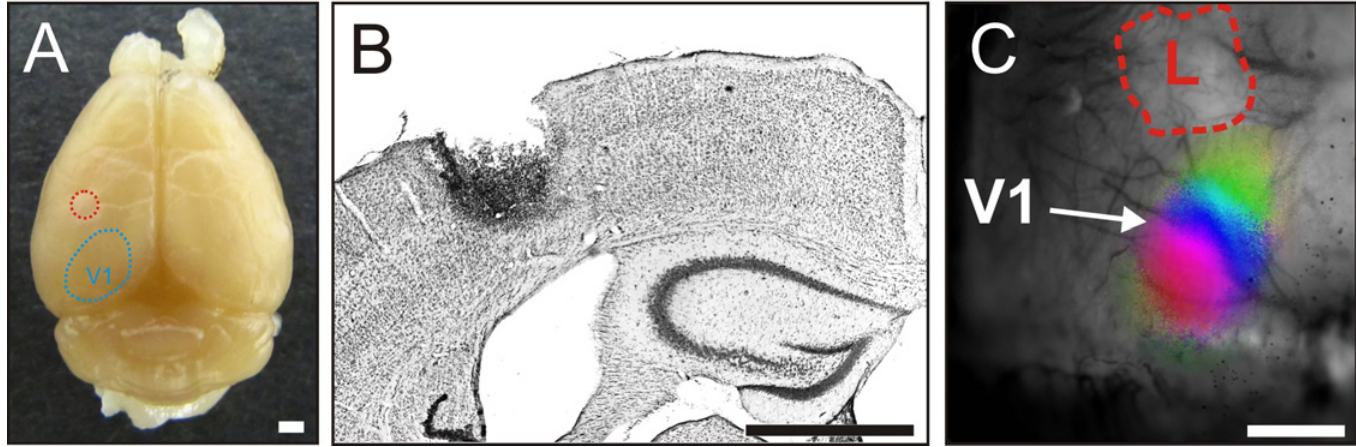
Fig 1. Location of the photothrombotically induced cortical stroke lesion in a PSD-95 KO mouse in S1 (PT, red dashed line). (A) Top view of a representative mouse brain illustrating the lesion location in S1, on average 1 mm anterior to the anterior border of the primary visual cortex (V1, blue dashed line). (B) Nissl-stained frontal section through the lesion (same animal as in A). (C) Higher magnification composite image of the superficial vascular pattern of the brain and the superimposed optically recorded retinotopic map of the binocular part of V1 of a PSD-95 KO mouse in which the PT-lesion (L) was very close to V1; nevertheless, OD-plasticity was present in this animal (average ODI = 0.00). Scale bar all, 1